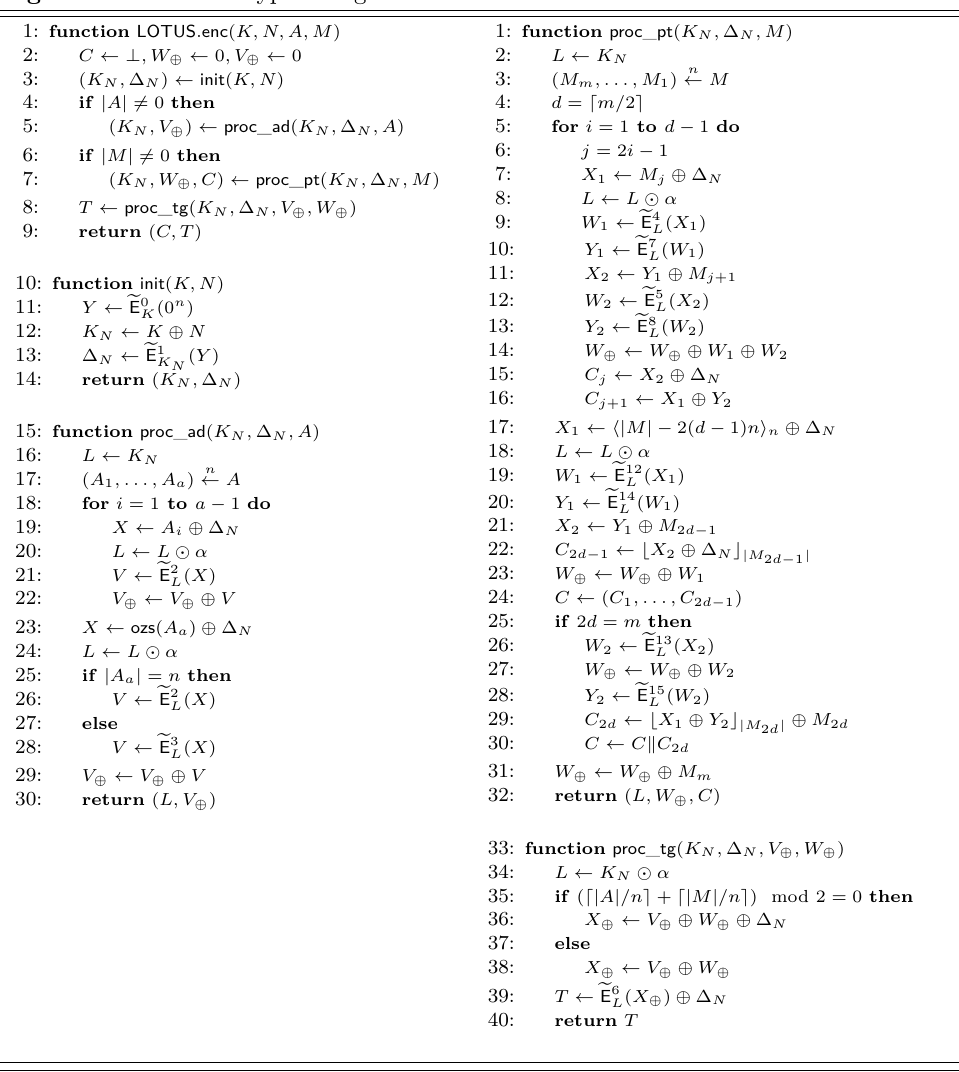
Algorithm 1 The encryption algorithm of LOTUS